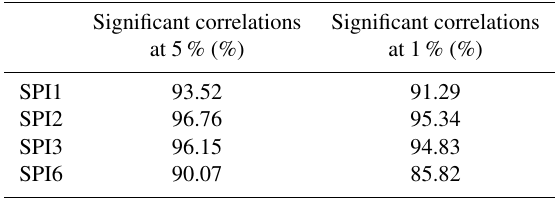
Table 8. Number of significant correlations (Pearson correlation co- efficient) between VHI and various SPI aggregation timescales. Val- ues are expressed as percentages evaluated with respect to the total number of grid cells (987).